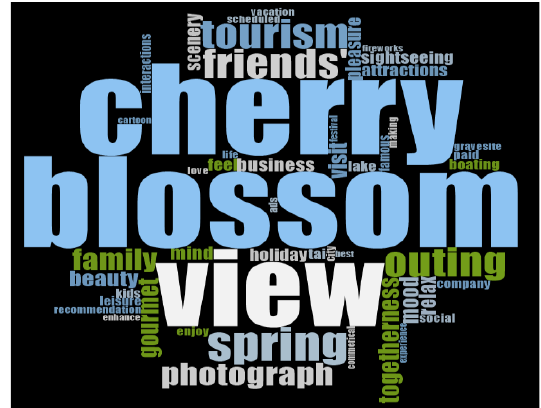
Figure 4. Stated motivations by tourists.